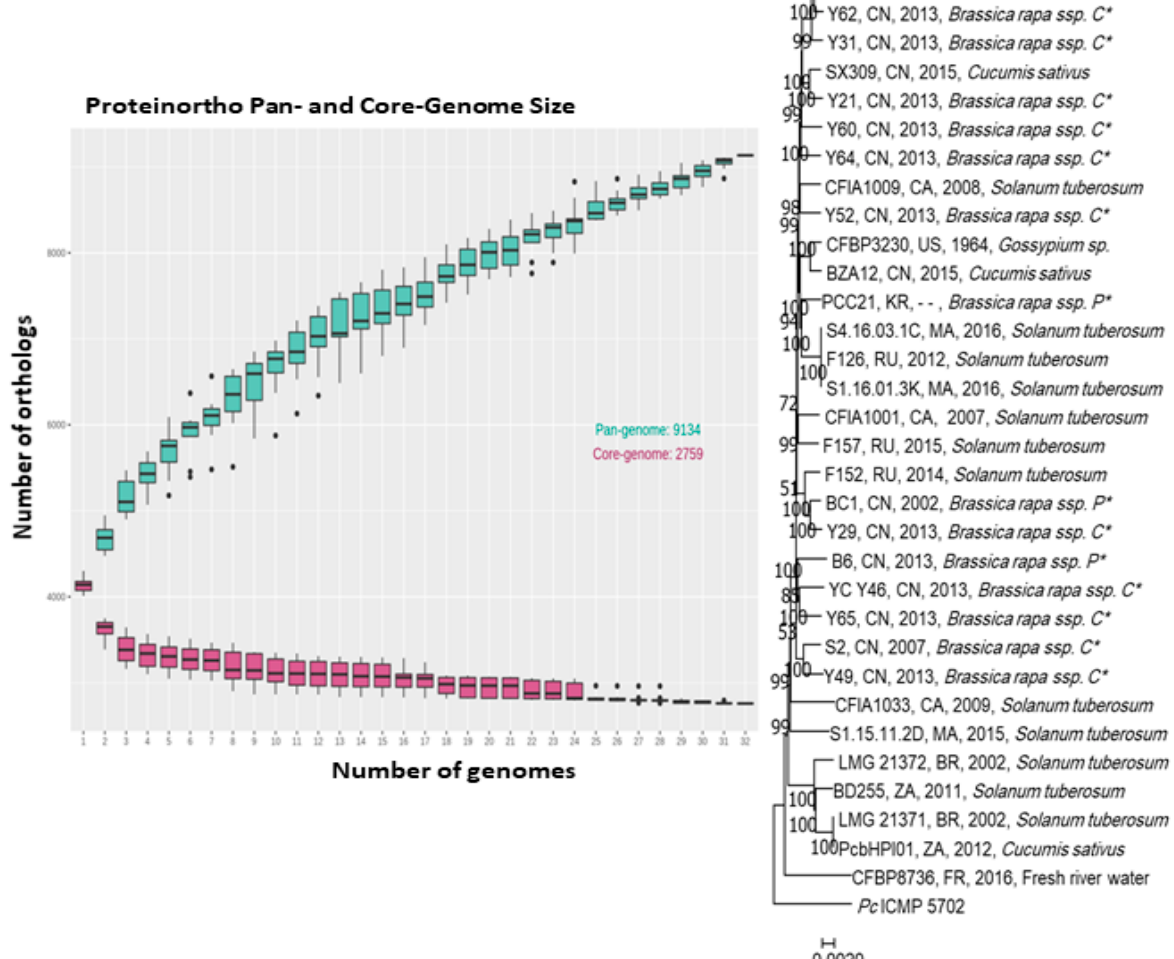
Figure 2. The genomic comparison of the available Pbr genomes in NCBI: ( A ) core and pan genome analysis, ( B ) phylogenomic analysis of the concatenated core genes of 30 Pbr strains was conducted using Proteinortho V.6 [56]. The genes were clustered based on the criteria of 50% identity on at least 50% of the length of the alignment, the P. carotovorum ICMP5702 was used as out of the group. (P *: Pekinensis; C *: Chinensis).